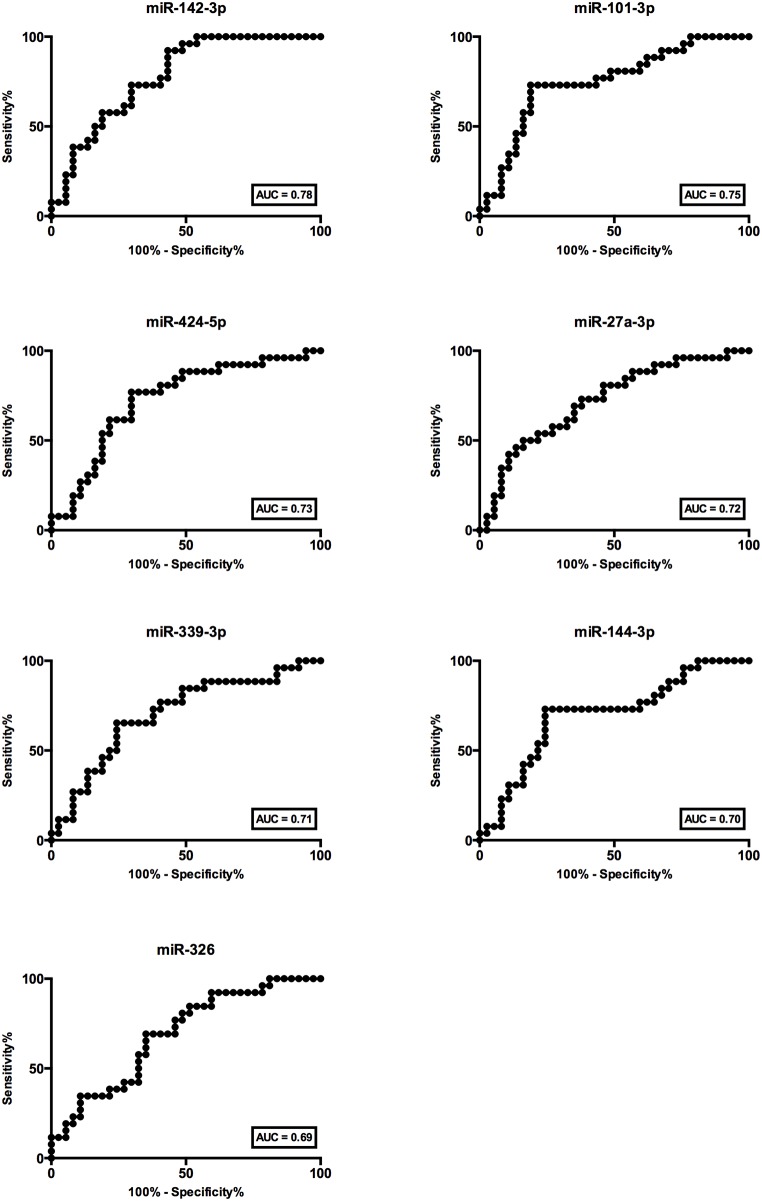
Receiver Operator Characteristic (ROC) analysis. Patients with and without acute cellular rejection could be discriminated by miR-142-3p (AUC = 0.78, CI95% = 0.67 to 0.89), miR-101-3p (AUC = 0.75, CI95% = 0.62 to 0.87), miR-424-5p (AUC = 0.73, CI95% = 0.60 to 0.86), miR-27a-3p (AUC = 0.72, CI95% = 0.59 to 0.85), miR-339-3p (AUC = 0.71, CI95% = 0.57 to 0.84), miR-144-3p (AUC = 0.70, CI95% = 0.56 to 0.83) and miR-326 (AUC = 0.69, CI95% = 0.56 to 0.82).